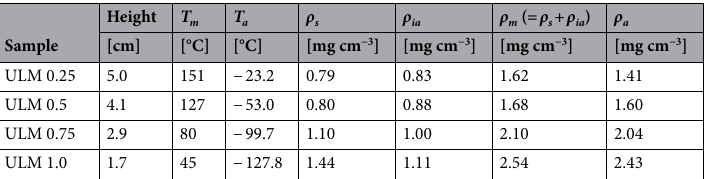
Table 1. Levitation height of each sample, temperature during levitation, temperature of ambient air, density of the skeleton of the samples, density of the air inside the samples, density of the samples, and density of ambient air (The values are the average of three measurements). T m : Temperature of materials. T a : Temperature of ambient air. ρ s : Density of skeleton with moisture. ρ a : Density of ambient air. ρ ia : Density of inner air. ρ m : Density of